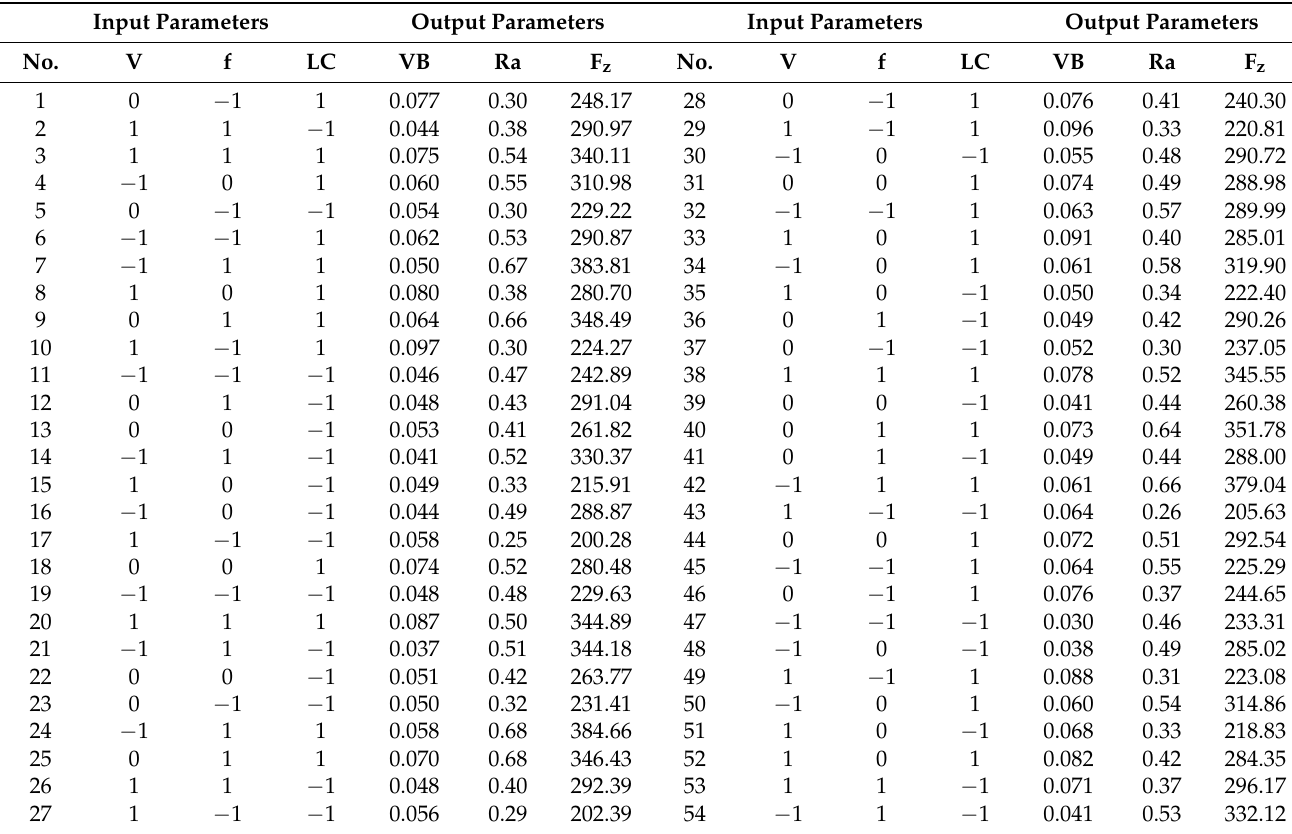
Table 2. Experimental results using the complete factorial array. No.: Number of the trials. LC: lubrication conditions. VB: flank wear. F z : main cutting force. f: feed speed. Ra: surface roughness.